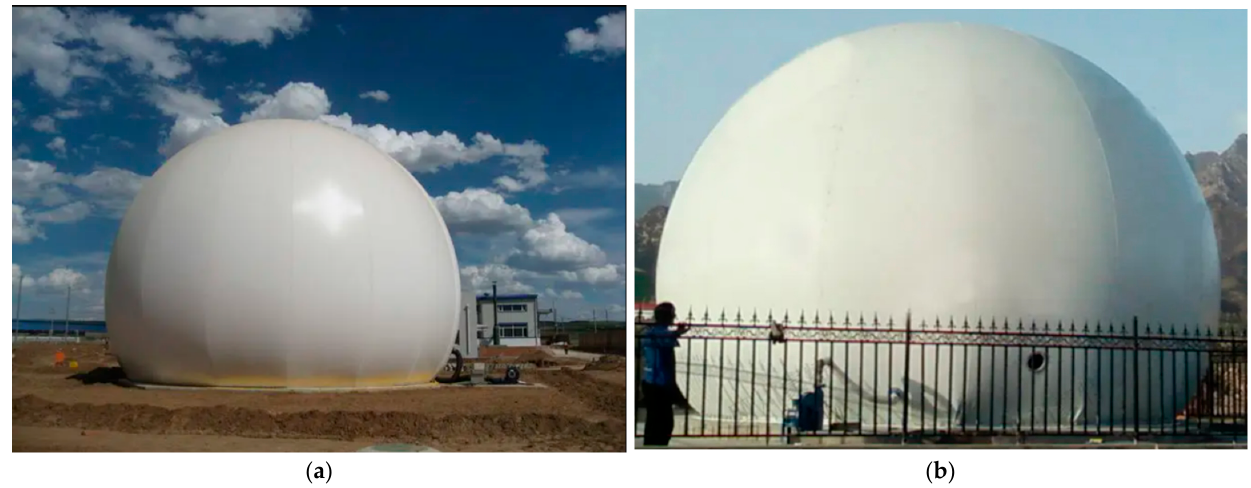
Figure 1. Spherical inflatable membrane structures: ( a ) The building in Xinjiang, China, 2020 (Address Source: www.hbjxmo.com/2661.html, accessed on 20 July 2022), ( b ) The building in Hebei,